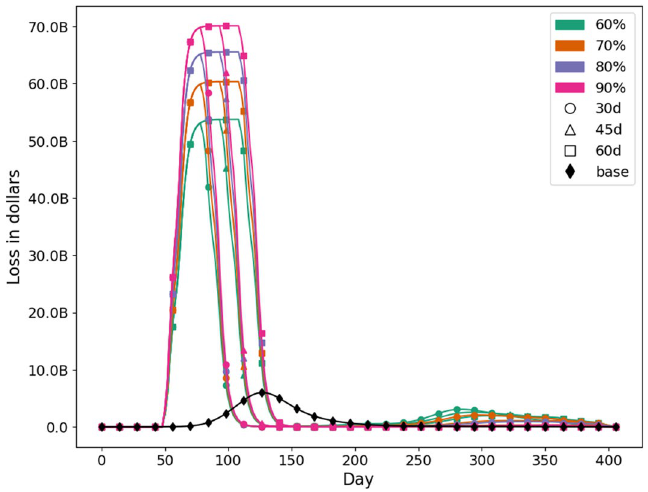
Figure 8. Daily I–O loss across all sectors for each scenario. The unmitigated base case is shown by the black curve where no NPIs are in place. Percentages are compliance to NPIs and “d” is the duration of SH order.